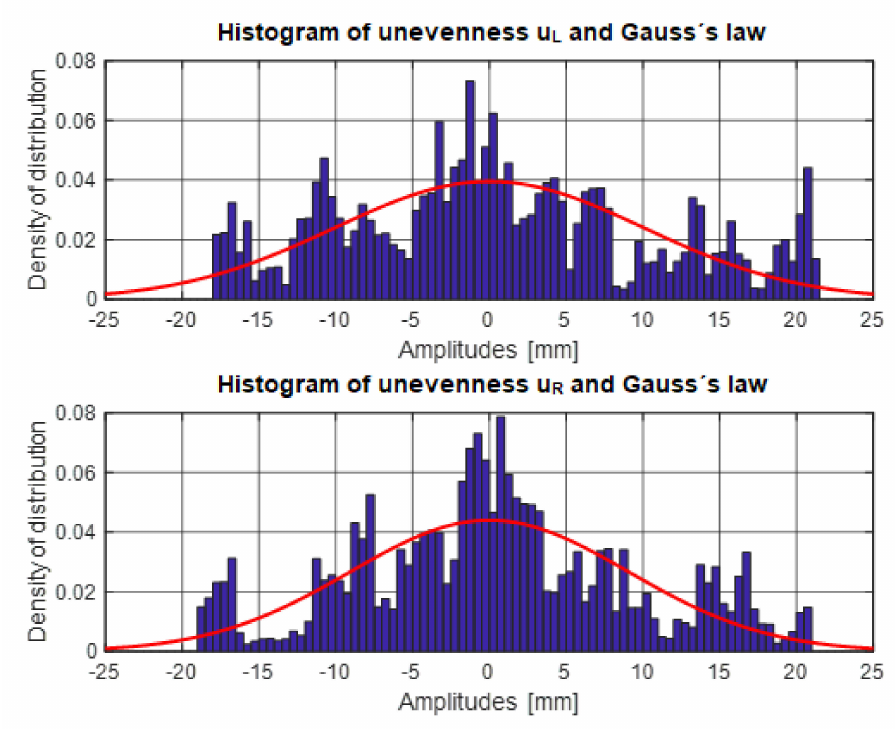
Figure 3. Histogram of unevenness and Gauss’s